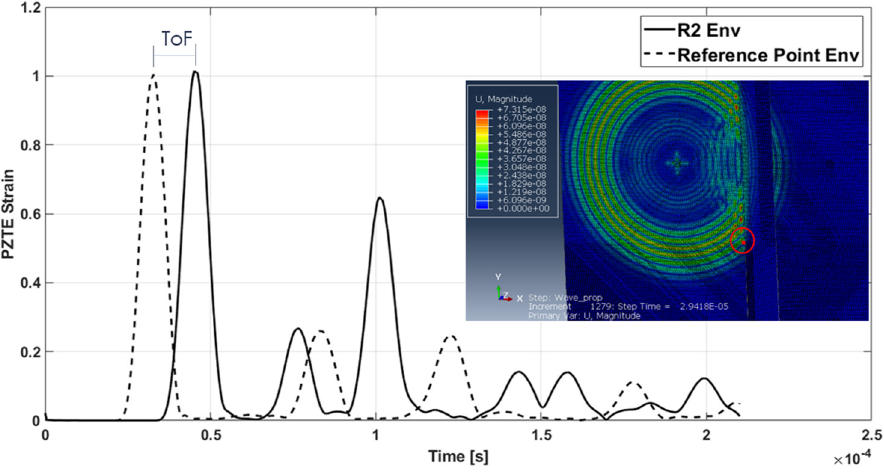
Figure 11. Waves ToF from reference point (red dot) to R2 sensor—aluminum stiffened